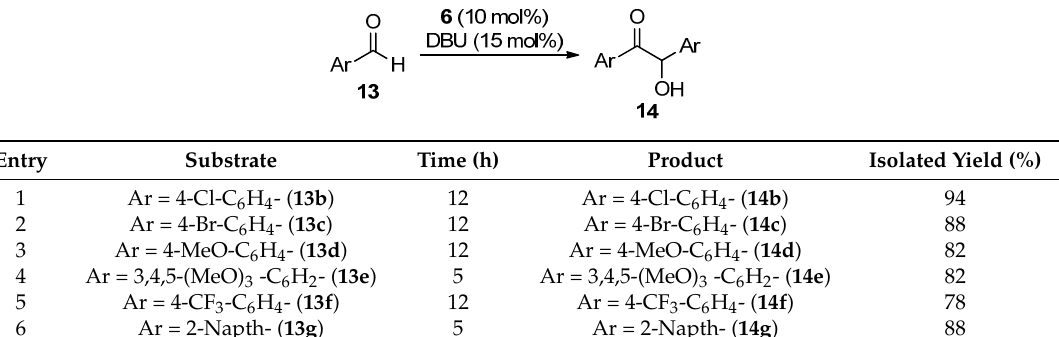
Table 2. Substrate scope of benzoin condensation reactions using polymer 6 a .